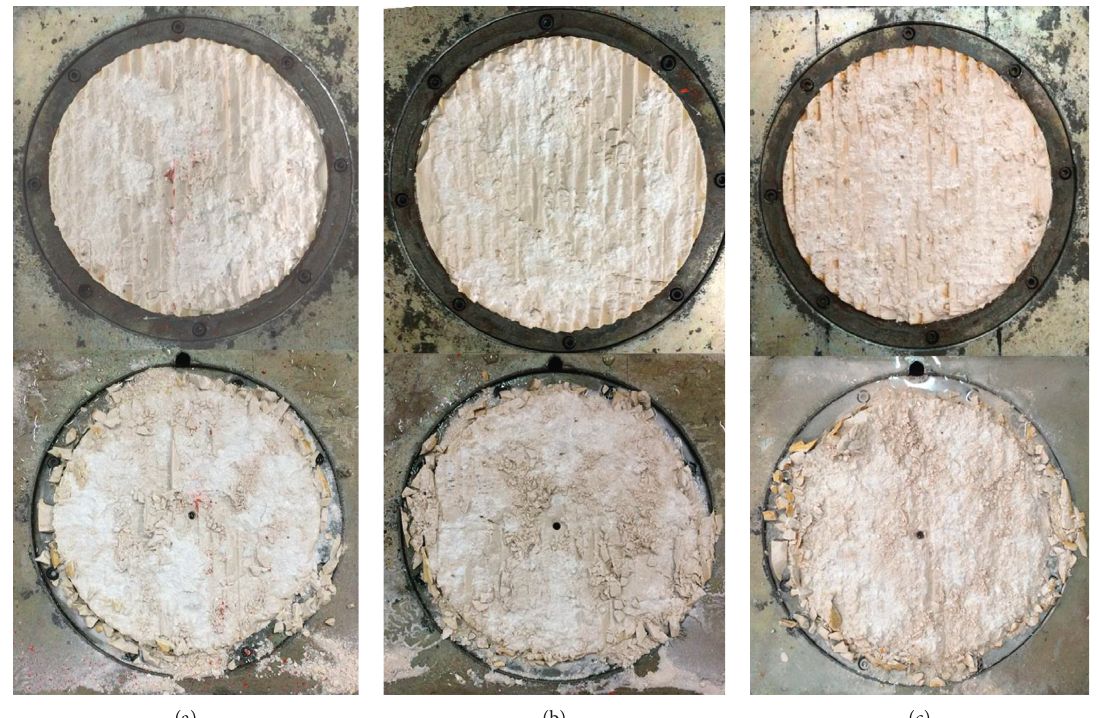
Figure 9: Group B fracture surfaces after the shear tests. (a) Case 2. (b) Case 4. (c) Case 5.